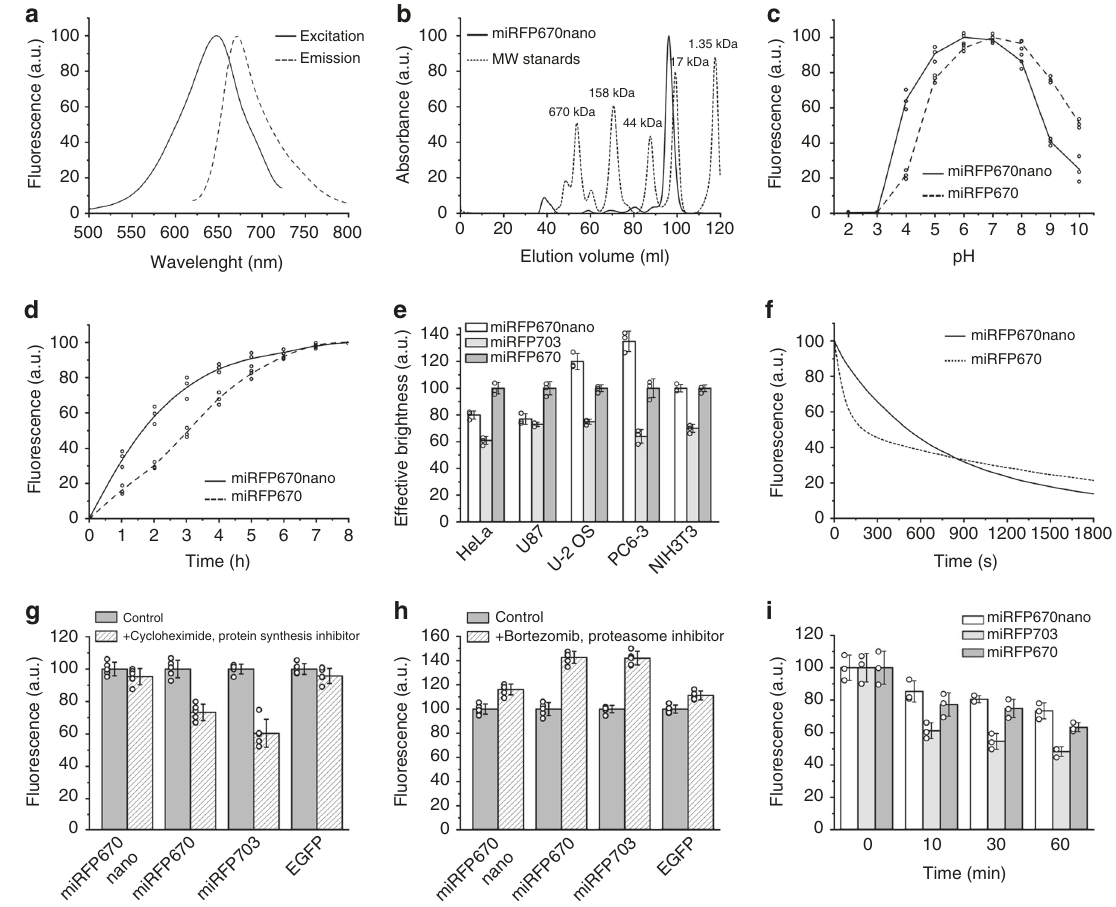
Fig. 2 Characterization of miRFP670nano. a Fluorescence excitation and emission spectra of miRFP670nano. b Size-exclusion chromatography of miRFP670nano at concentration 10mgml − 1 and indicated molecular weight standards. miRFP670nano with polyhistidine tag and linker runs as a monomer with the apparent molecular weight of 18.8 kDa. c pH dependencies of NIR fl uorescence for miRFP670nano and miRFP670. d Kinetics of miRFP670nano and miRFP670 maturation. Time “ 0 ” corresponds to the beginning of the 1-h-long pulse-chase induction of the protein expression in bacteria. e